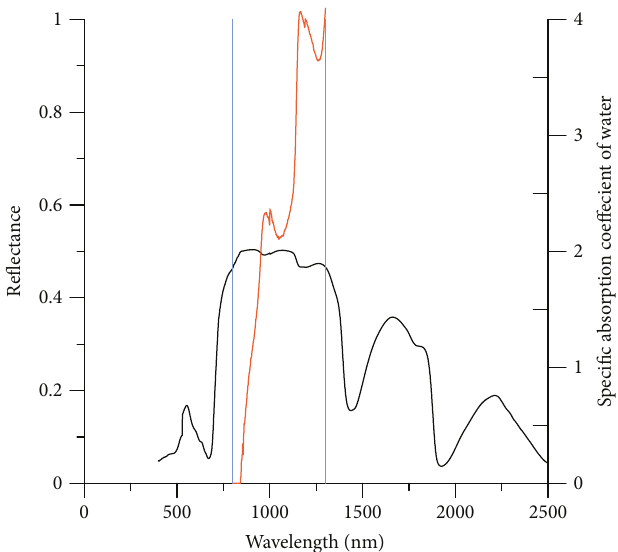
Figure 2: Leaf re fl ectance in 400 – 2500 nm and the speci fi c absorption coe ffi cient of water in the wavelength range of 800 –